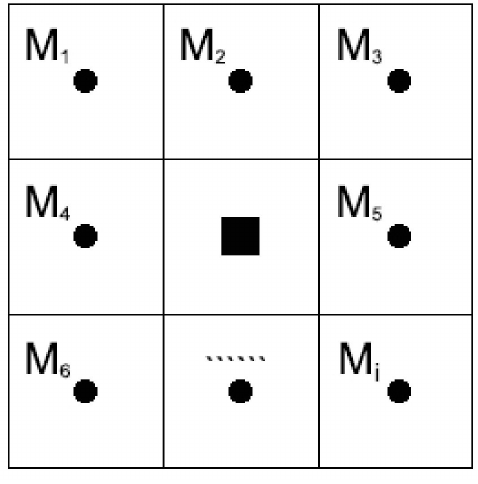
Figure 2. Center of gravity model